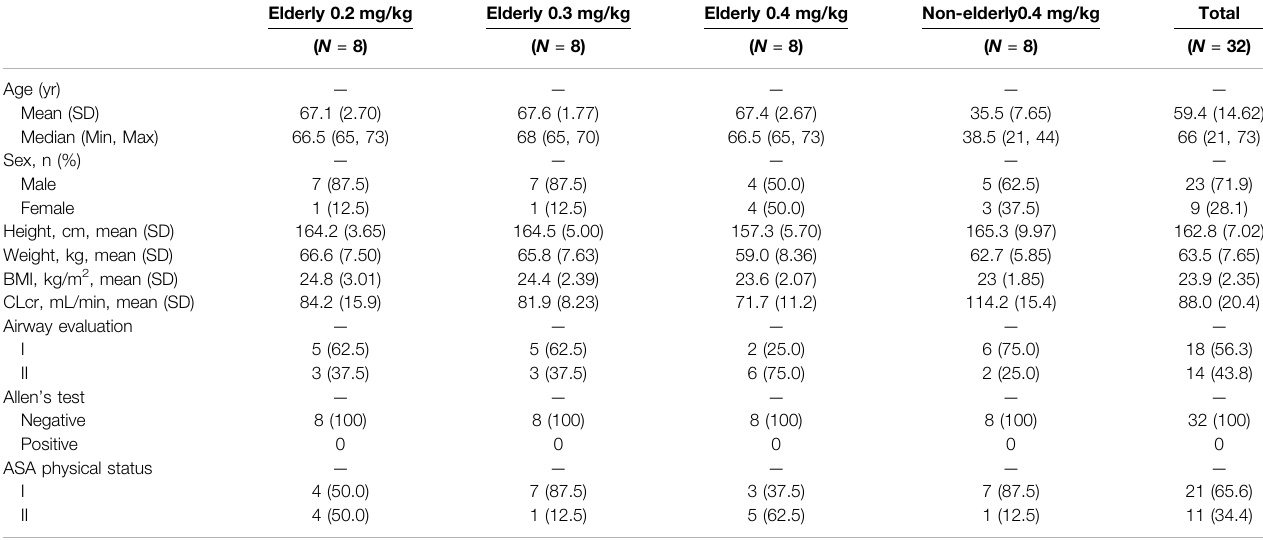
TABLE 1 | Subjects ’ demographic and baseline characteristics.